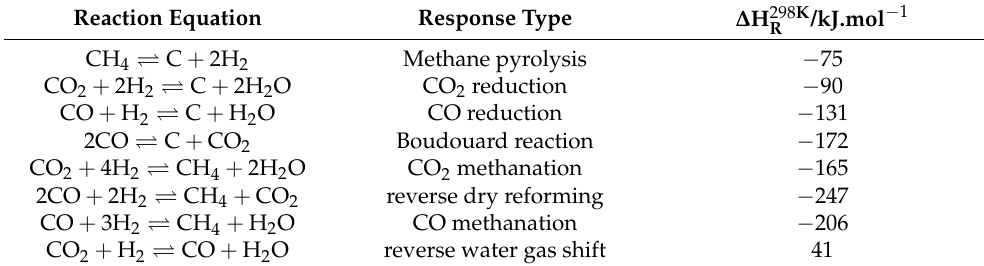
Table 13. CO 2 methanation: main reactions and side reactions [384].